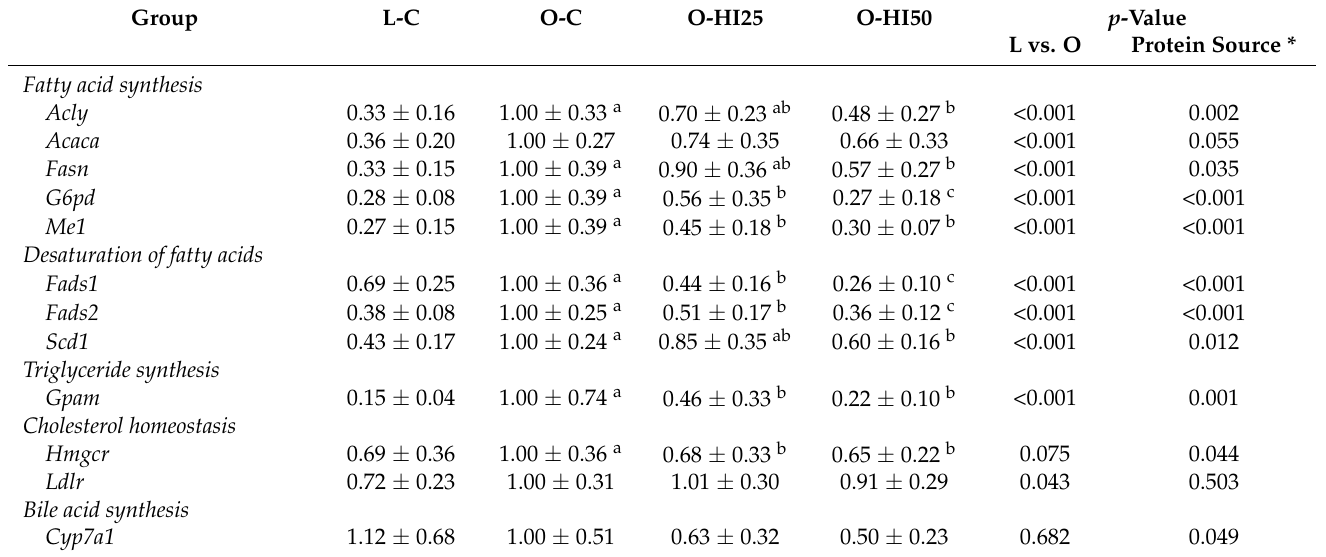
Table 6. Hepatic mRNA levels of genes involved in lipid metabolism of lean rats fed a control diet with casein (L ‐ C) and obese rats fed either the control diet with casein (O ‐ C) or the control diet in which 25% (O ‐ HI25) and 50% (O ‐ HI50) of the protein from casein was replaced with protein from HI larvae meal for 4 weeks.